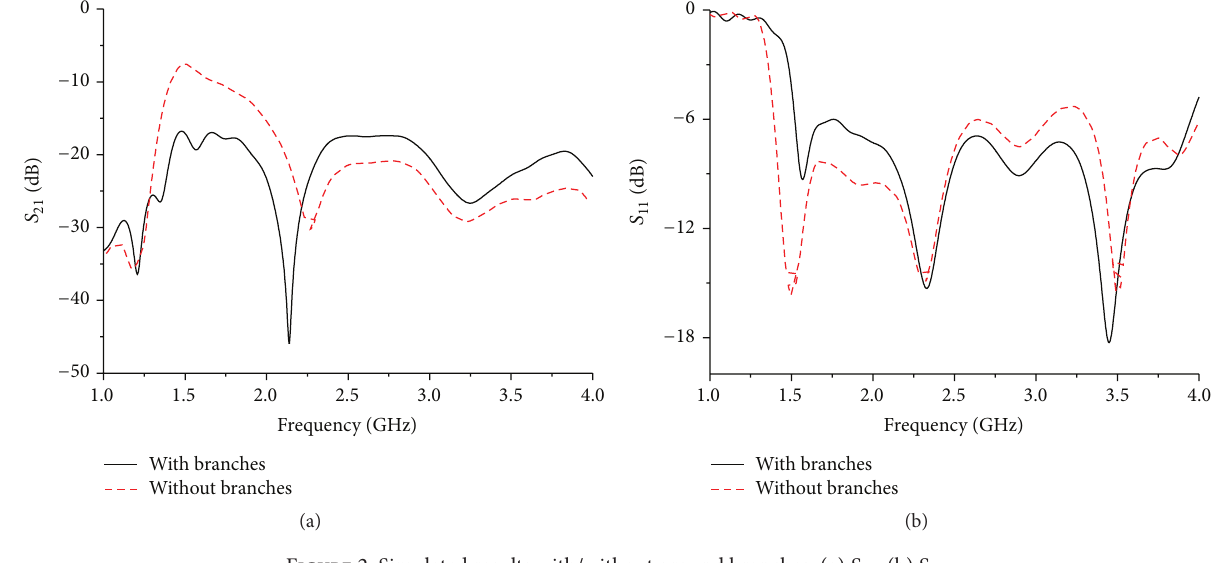
Figure 2: Simulated results with/without ground branches: (a) 𝑆 21 ; (b) 𝑆 11 .